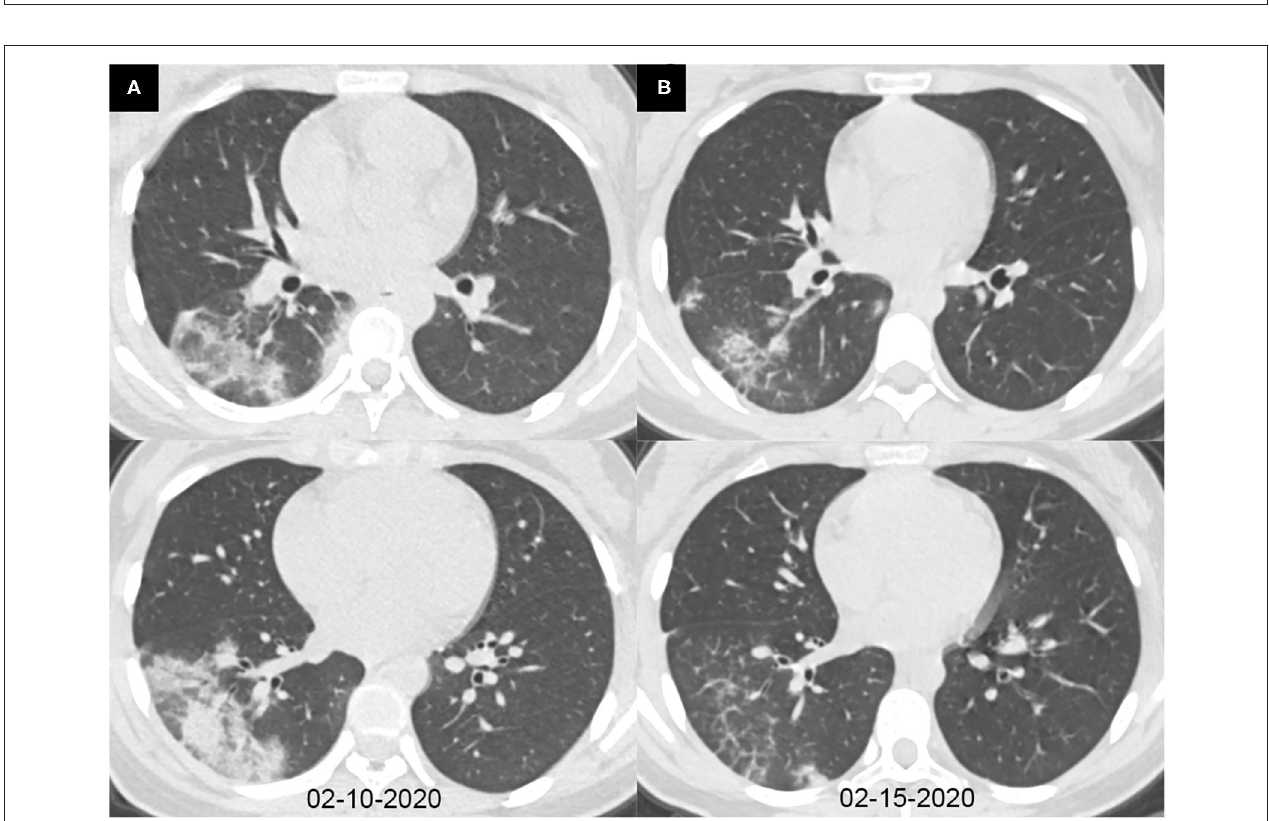
FIGURE 3 | Axial chest CT images of a 14-year-old girl with fever and cough for 6 days. Pharyngeal swab RT-PCR tests were performed on February 9, 2020, with positive results, and on February 6, 13, and 15, 2020, with negative results. Chest CTs were obtained on February 10 (A) and 15, 2020 (B) . (A) Consolidations were seen in the right lower lobe. (B) The consolidations were obviously